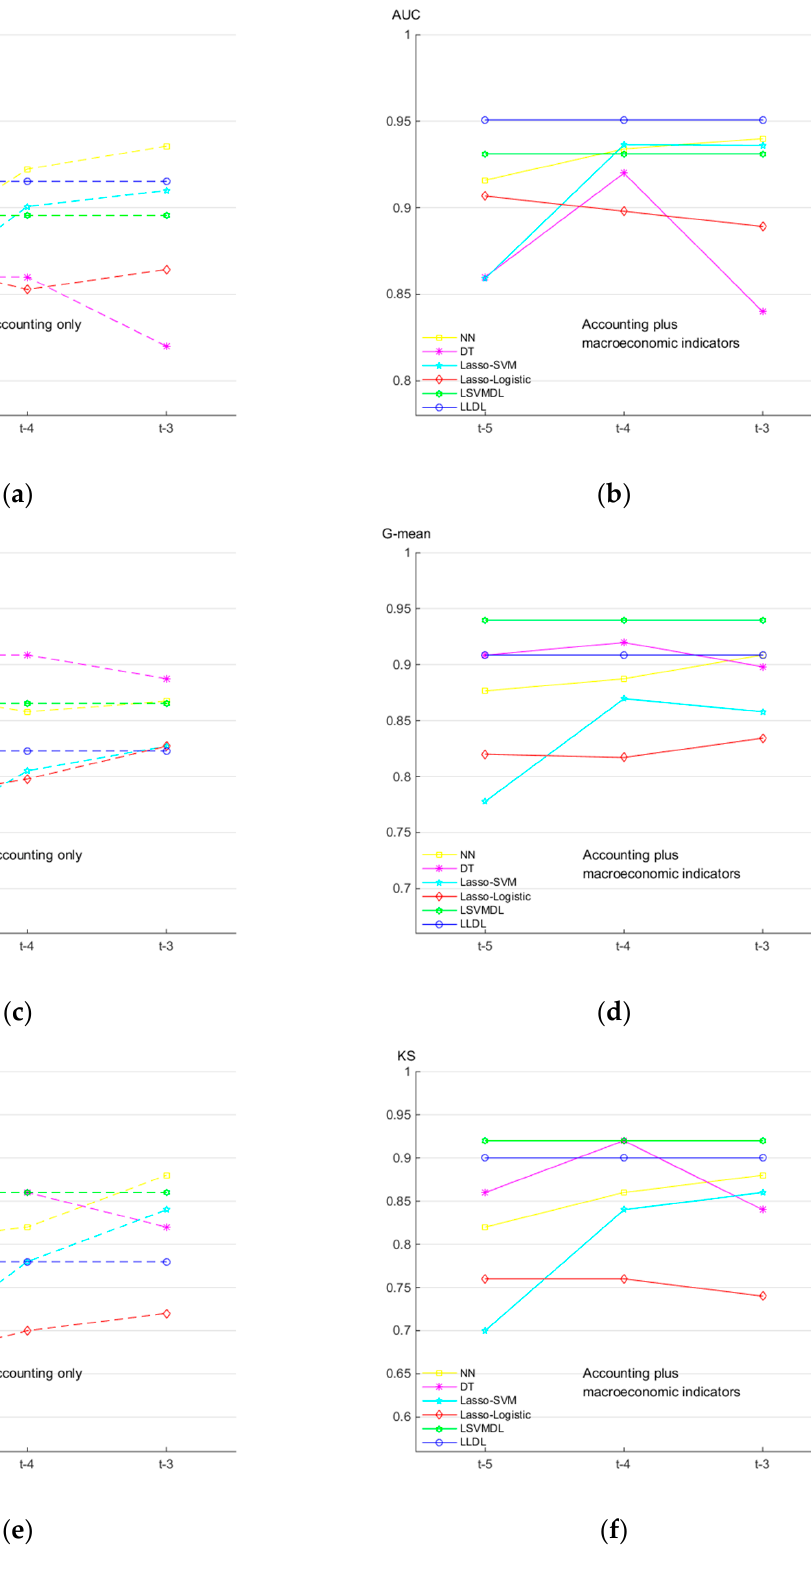
Figure 2. Predictive performance of NN, DT, lasso–SVM, and lasso–logistic models on three different time window datasets, respectively, and our models on three consecutive time window datasets, evaluated by AUC for ( a ) and ( b ), G-Mean for ( c ) and ( d ), and KS for ( e ) and ( f ).